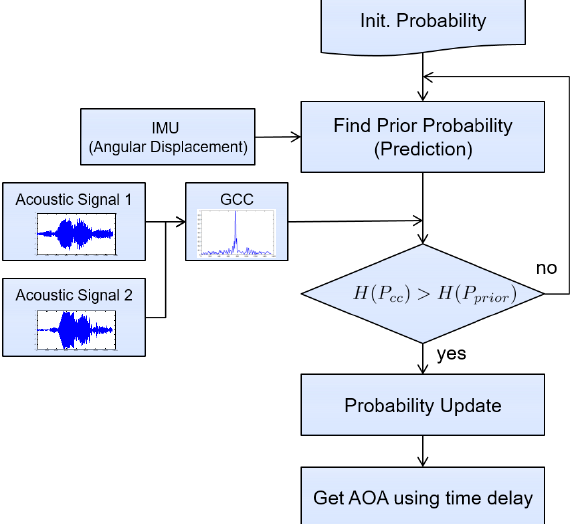
Figure 2. A flowchart for the estimation of directional angle using a marine vehicle equipped with two